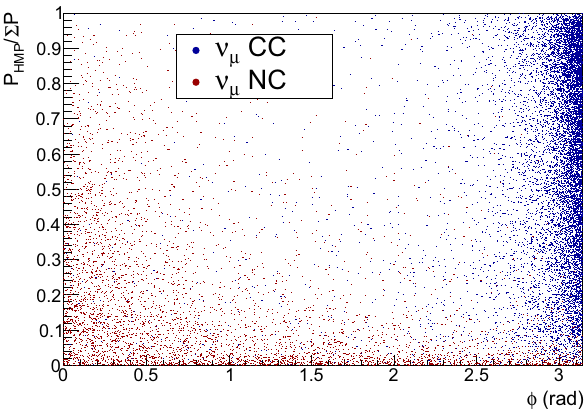
NC (red) interactions. The MC sample is generated by Genie with the FASER ν μ spectrum, and the same smearing as in Sect. 4.3 is applied. Right : Same plot for neutral hadron backgrounds